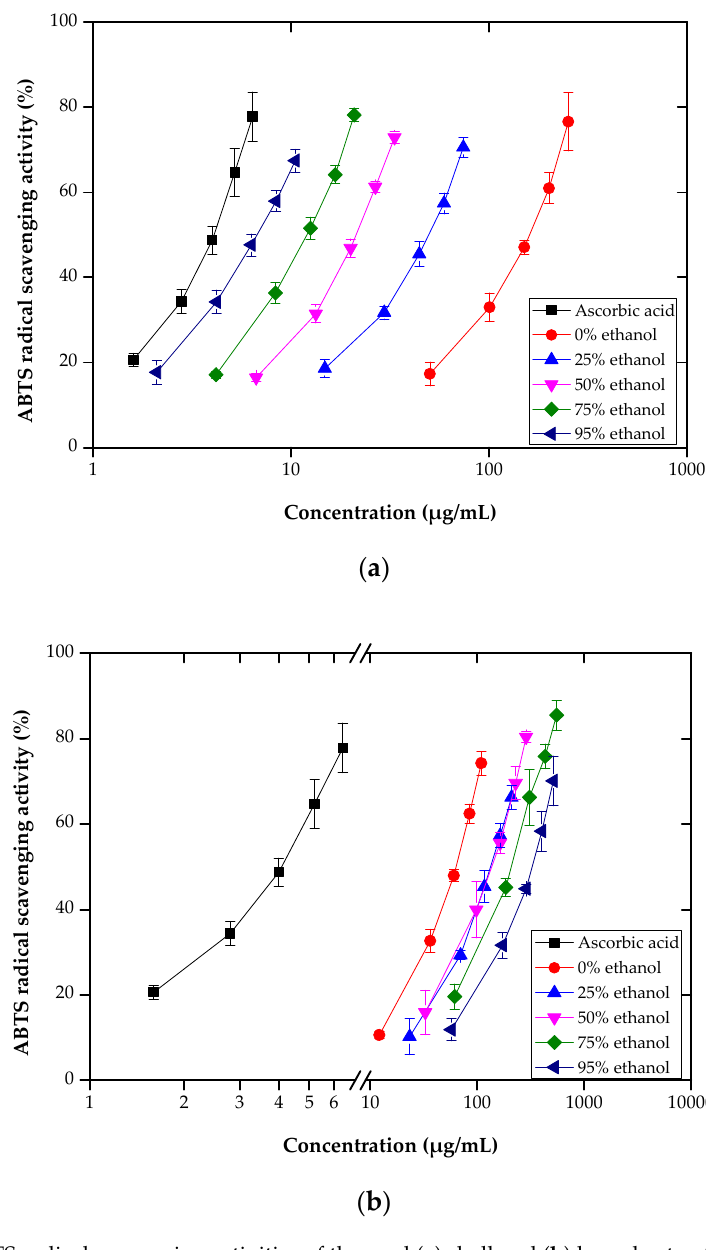
Figure 3. ABTS radical scavenging activities of the seed ( a ) shell and ( b ) kernel extracts from different ethanol solutions.